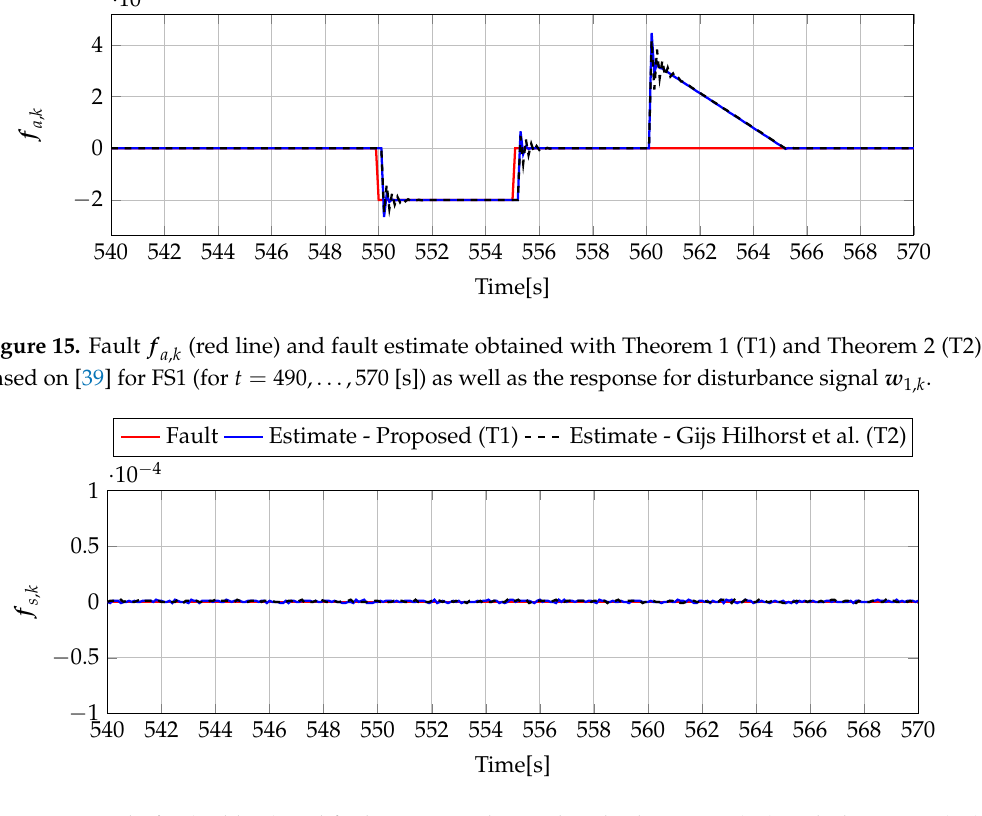
Figure 16. Fault f (red line) and fault estimate obtained with Theorem 1 (T1) and Theorem 2 (T2) s , k based on [39] for FS1 (for t = 540, . . . ,570 [s]) as well as the response for disturbance signal w 1, k .